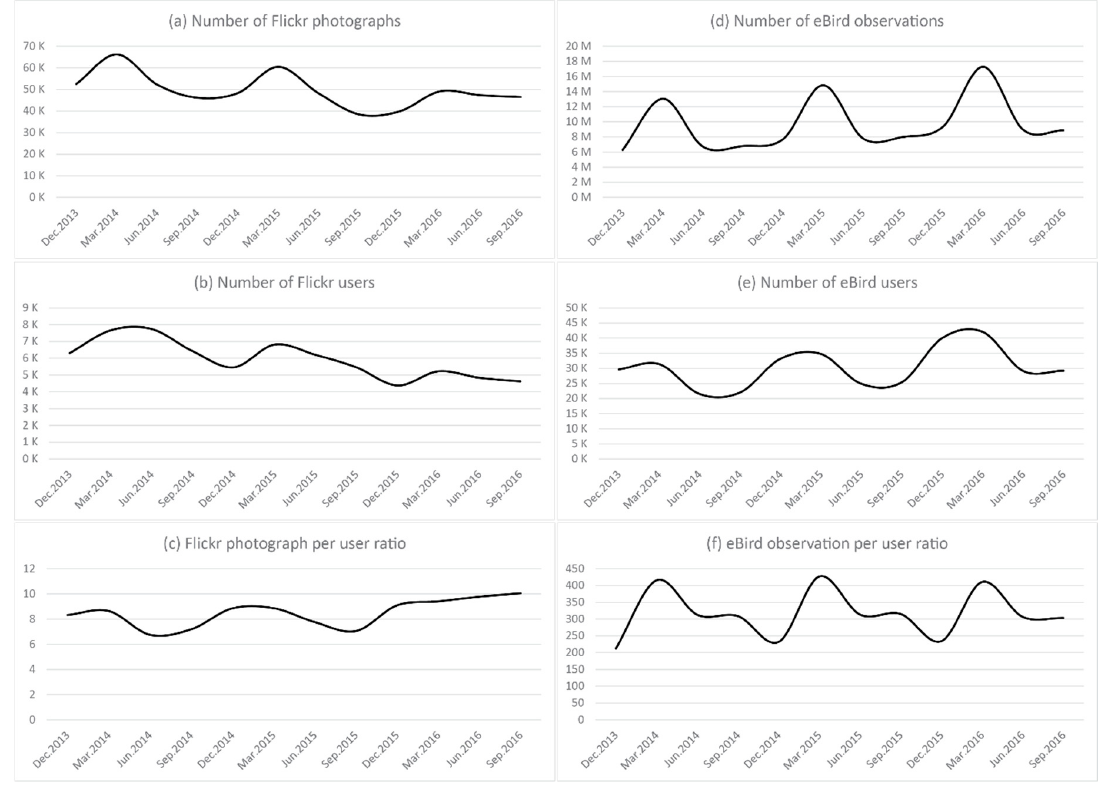
Figure 7. Temporal patterns of YOLO-detected Flickr bird images and eBird observations.